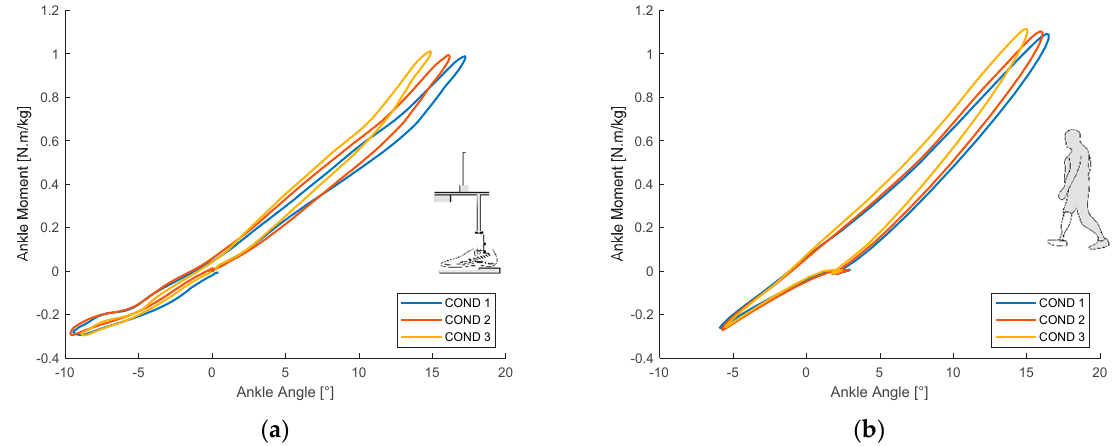
Figure 7. Ankle moment versus ankle angle during level-ground walking for three stiffness settings-condition 1 (softest), condition 2 (mid), and condition 3 (stiffest): ( a ) test machine results and ( b ) biomechanical test results–average of five users.